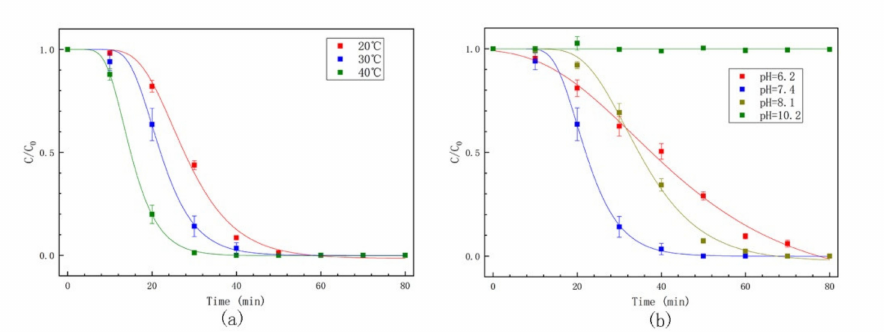
Figure 5. ( a ) Degradation of MO (0.5 mM) by sulfide (6 mM) with RCB800 at 20, 30, and 40 ◦ C. ( b ) Degradation of MO (0.5 mM) by sulfide (6 mM) with RCB800 at pH 6.2, 7.4, 8.1, and 10.2. The dosage of materials was 100 mg/L, pH = 7.4, and the temperature was 30 ◦